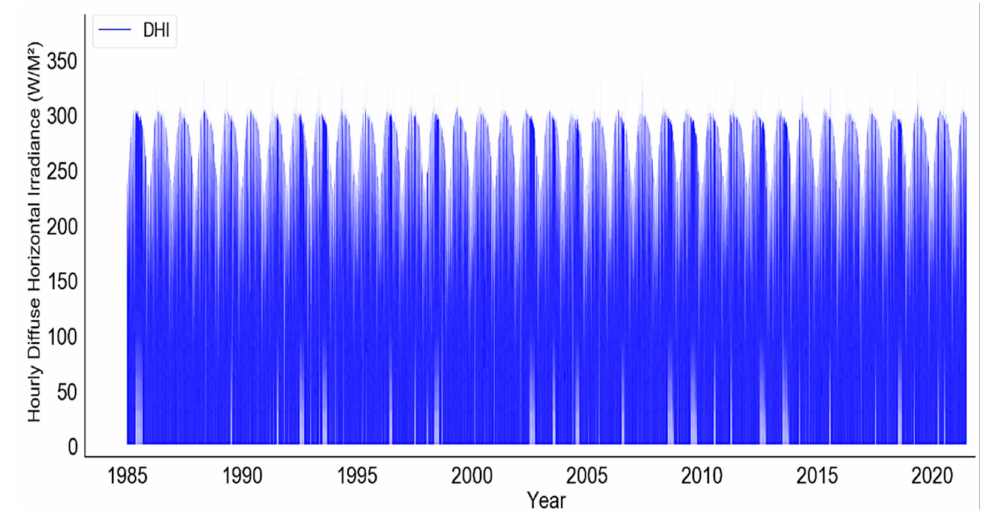
Figure 10. Hourly intervals historical performance of the DHI over 36 years.